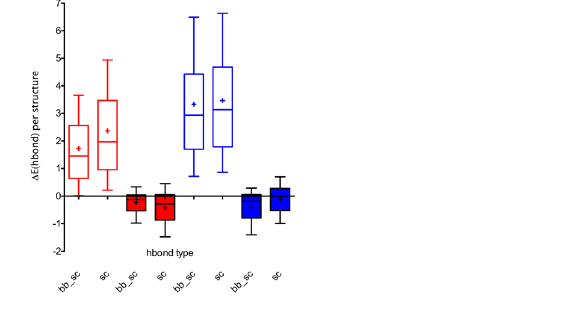
Figure 6 . High-charge variant hydrogen bond energy changes per structure (600 total) . In high-charge AvNAPSA designs (AvNAPSA cutoff of 150), removal of hydrogen bonds costs 1.5 to 3 Rosetta energy units per structure (empty bars). In contrast, Rosetta designs with the same net charge preserve hydrogen bonds (solid bars).